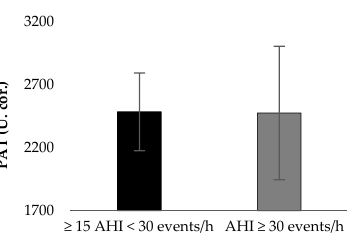
Figure 2. Oxidative stress marker on reactive oxygen metabolites’ levels (d-ROM) between groups.